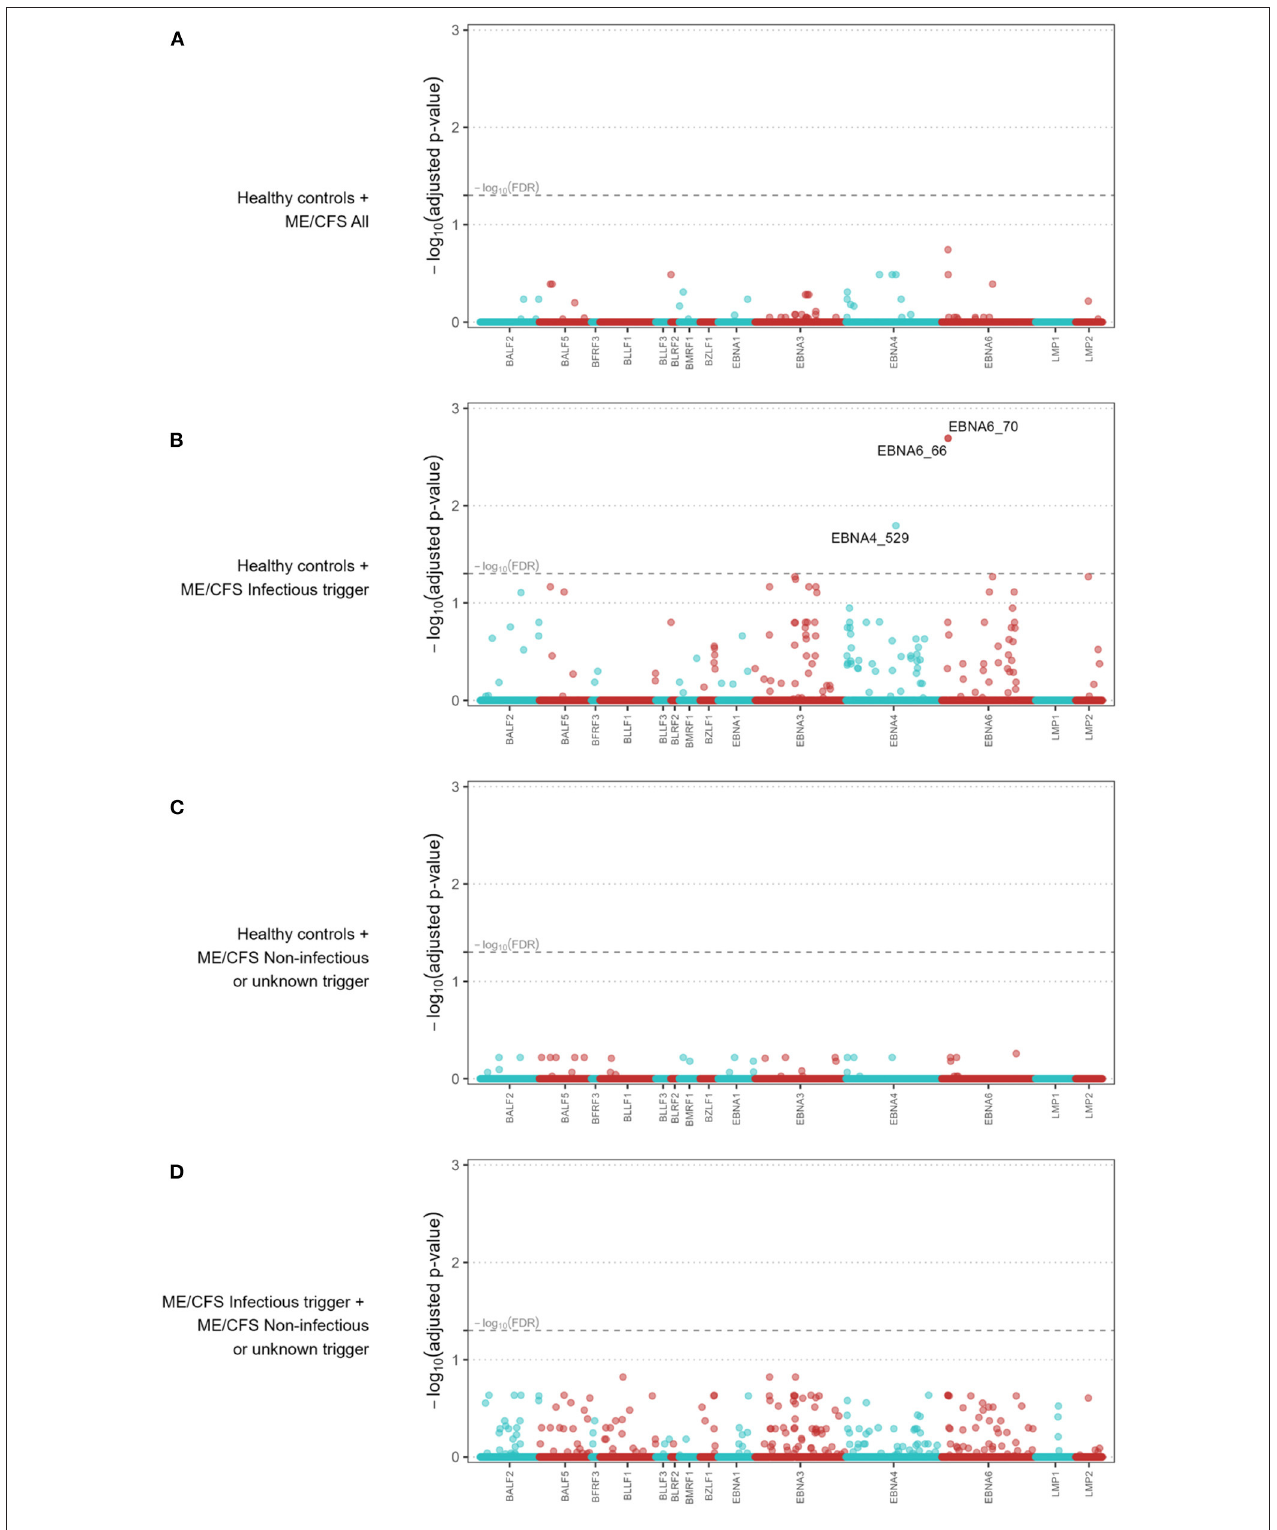
FIGURE 2 | Antibody-wide association analyses when comparing all the ME/CFS patients to healthy controls (A) , ME/CFS patients with an infectious trigger to healthy controls (B) , ME/CFS patients with a noninfectious or unknown trigger to healthy controls (C) , and ME/CFS patients with an infectious trigger to the remaining patients (D) . The x -axes comprise each antibody while the y -axes represent the − log 10 (adjusted p -value) of the respective association. In the x -axes, the antibodies